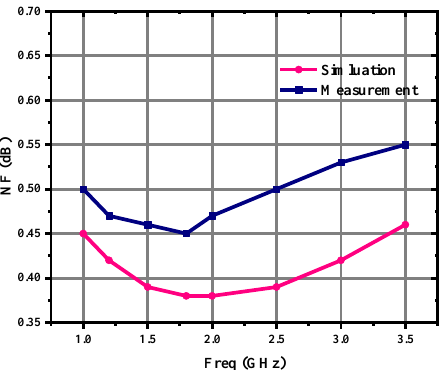
Figure 10. NF performance in the frequency range 1 GHz–3.5 GHz. To define large-signal behavior, the linearity measurements were performed for the LNA. Figure 11 present the measured OP1dB and OIP3 results with simulated data according to the single-tone output power test and two-tone third-order intermodulation test. The LNA processes the OP1dB better than +19 dBm and OIP3 greater than +31.5 dBm by 3.5 GHz. Due to transistor large-signal model errors, the measured linearity data is about 2 dB lower than the simulated results.